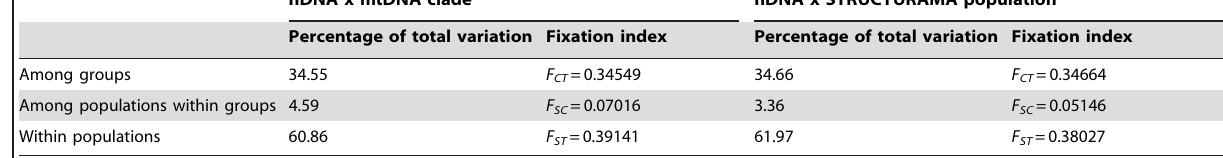
Table 2. Analysis of Molecular Variance